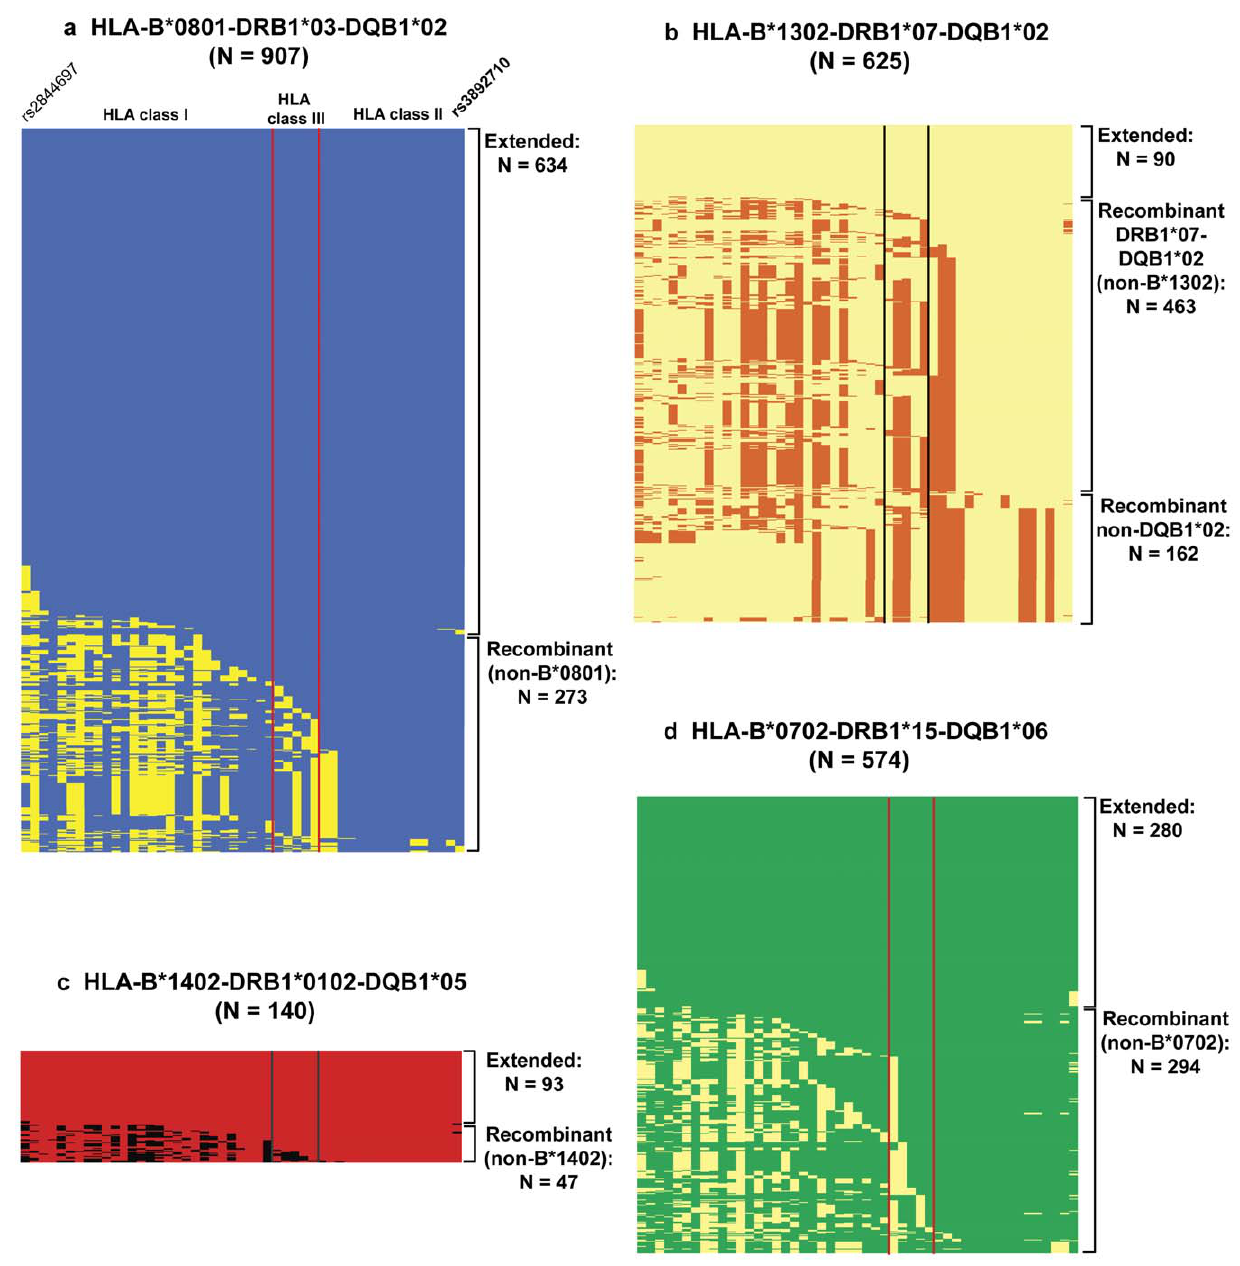
Figure 2. Representation of the haplotypes carrying the HLA-DRB1 alleles most associated with IgAD. Reconstructed extended haplotypes using the final set of 49 SNPs spanning the classical HLA region were aligned to the respective extended haplotype. Shown here are the reconstructed haplotypes carrying the HLA-DRB1*03 (a), -DRB1*07 (b), -DRB1*0102 (c) and -DRB1*15 (d) alleles. Recombinant haplotypes represent all haplotypes containing the same HLA-DRB1 allele in association with a different HLA-B allele, as compared to the respective extended haplotype. Vertical bars delimit the HLA Class III region. N, Number of haplotypes. Haplotype frequencies in the Swedish/Icelandic, Spanish and Icelandic cohorts are detailed in Table